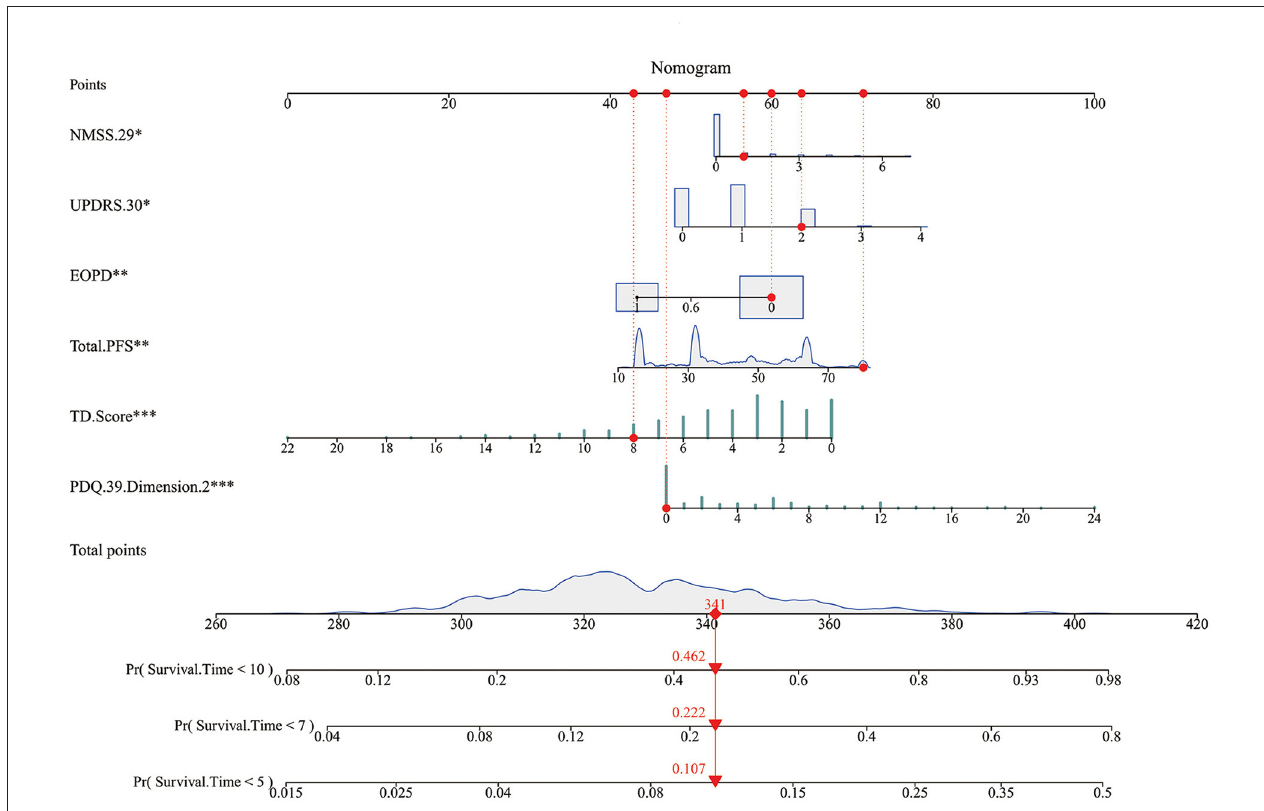
FIGURE 3 | The nomogram. Non-Motor Symptoms Scale (NMSS).29: unexplained weight change; Unified Parkinson’s Disease Rate Scale (UPDRS) 0.30: impaired balance; EOPD: early-onset PD; Total. Parkinson’s Fatigue Scale (PFS): degree of fatigue; tremor dominant (TD). Score: degree of tremor symptom; Parkinson’s Disease Questionnaire (PDQ).39. Dimension.2: Activities of Daily Living. Every factor has a point, and total points are the sum of the point of each factor, corresponding to the probability of FOG occurring at different survival times.